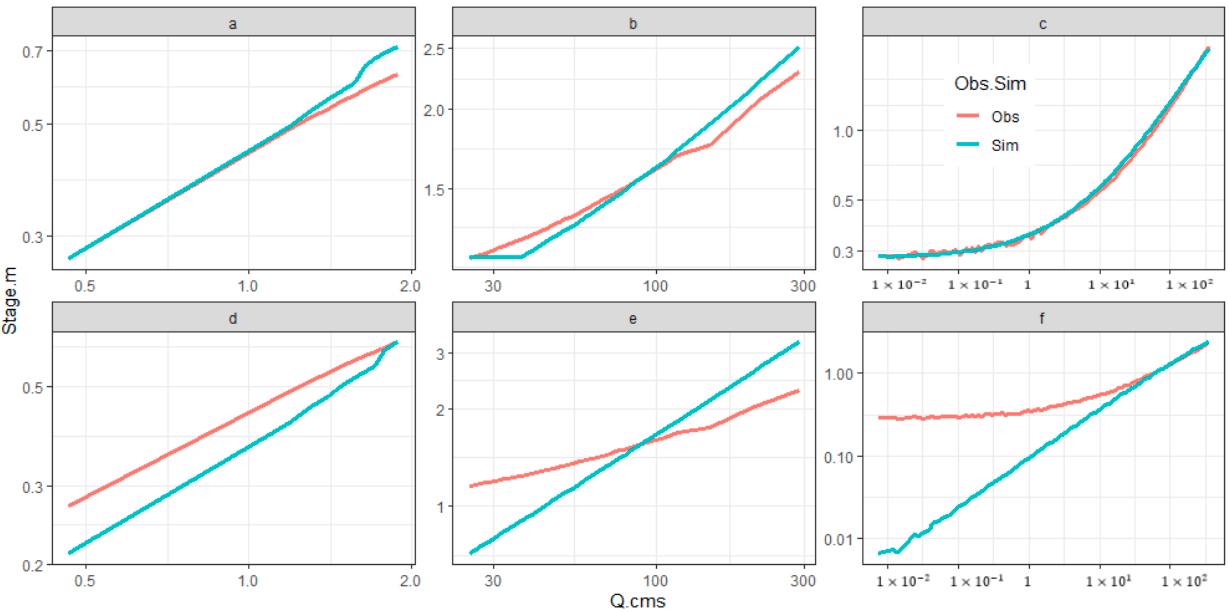
Figure 9. Selected rating curve comparisons for ( a ) LA River (F300) at low flows with datum adjustment, ( b ) LA River (F300) at high flows with datum adjustment, ( c ) Rio Hondo (USGS 11102300) with datum adjustment, ( d ) LA River (F300) at low flows without datum adjustment, ( e ) LA River (F300) at high flows without datum adjustment, and ( f ) Rio Hondo (USGS 11102300) without datum adjustment. In some cases, calibration is more successful with datum adjustment, as for USGS 11102300 and F300 (high flows) (panels ( b , c )); in others, it produces a better apparent fit but unrealistic result, as with F300 (low flows) (panel ( a )), where the datum-adjusted calibration resulted in n = 0.292 for a concrete channel (typical roughness coefficients for concrete are between 0.011 and 0.020 [40]). In such cases, unadjusted calibration tends to produce more realistic results, although the apparent fit does not tend to be as good; datum adjustment should therefore only be used when the user is confident there is an actual datum gap.